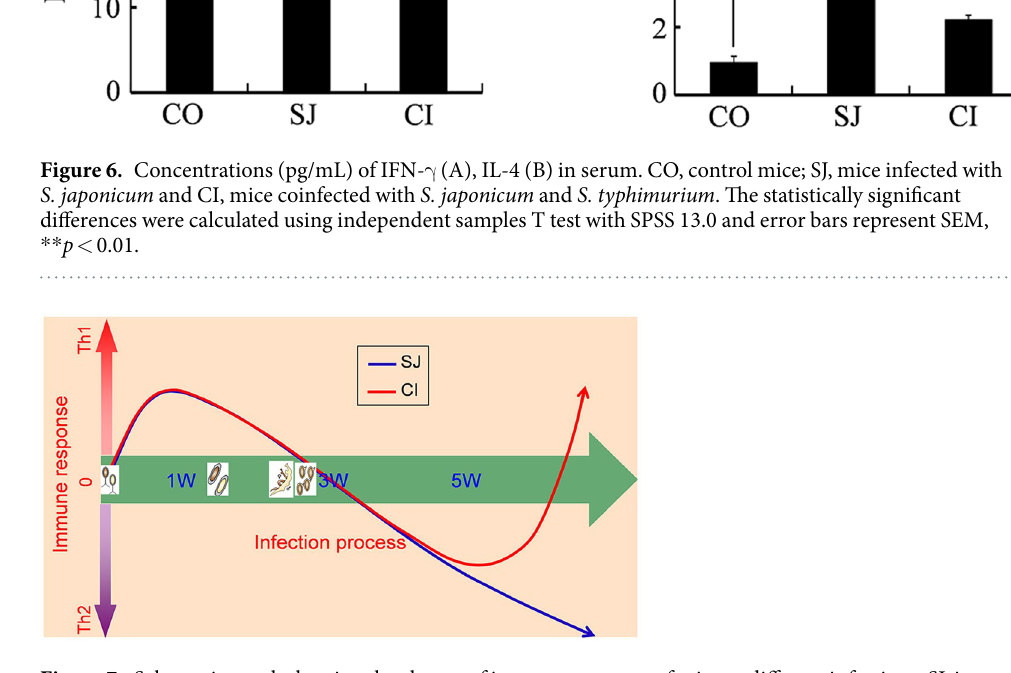
Figure 7. Schematic graph showing the change of immune response of mice to different infections. SJ, immune response of mice infected by S. japonicum only; CI, immune response of mice infected by S. japonicum firstly then by S. typhimurium ATCC14028 five weeks later. Th1, type 1-T helper cell polarized immune response; Th2, type-2 T helper cell polarized immune response. 1 W, 3 W, 5 W, different time points after